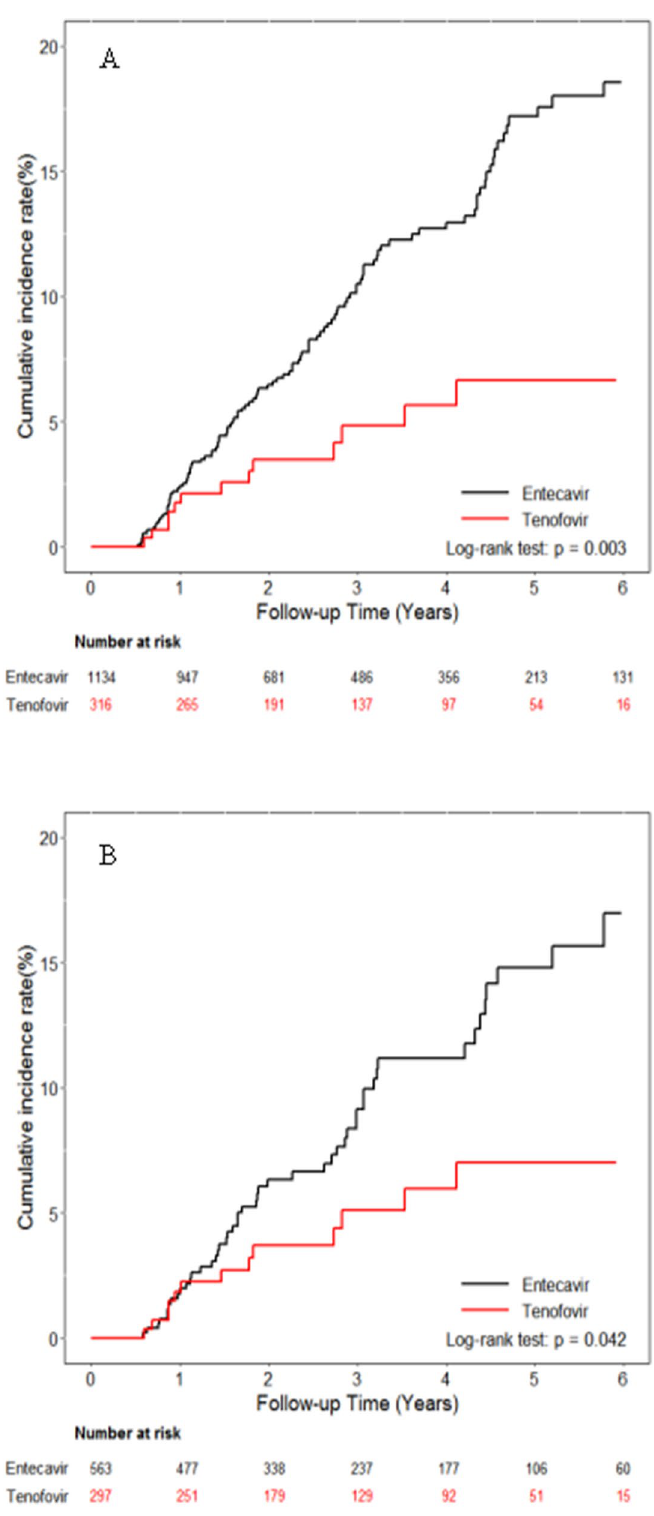
Figure 2. Cumulative incidences of HCC in patients with decompensated liver cirrhosis. ( A ) Entire cohort ( B ) Propensity score matching